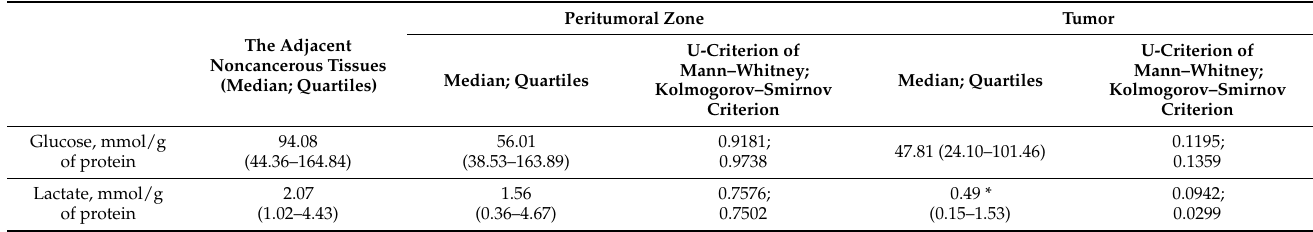
Table 2. Indicators of carbohydrate metabolism in